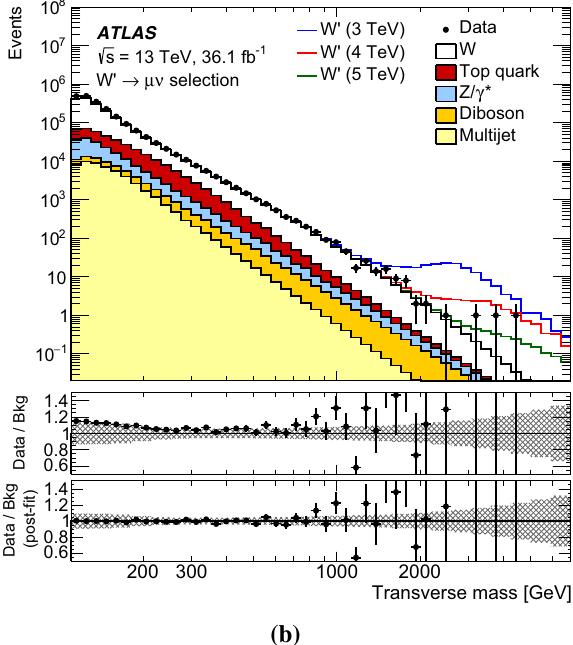
to the expected background, with vertical bars representing both data and MC statistical uncertainties. The lower panels show the ratios of the data to the adjusted expected background (“post-fit”) that results from the statistical analysis. The bands in the ratio plots indicate the sum in quadrature of the systematic uncertainties discussed in Sect. 6, including the uncertainty in the integrated luminosity